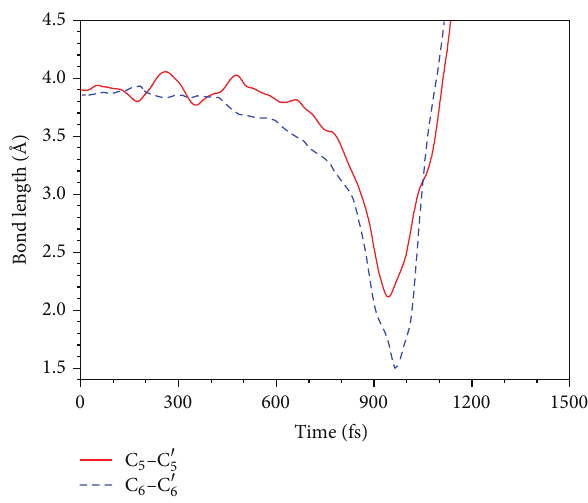
Figure 3: The variations with time of the lengths between the C 5 and C 󸀠 5 atoms and the C 6 and C 󸀠 6 atoms in two stacked cytosine